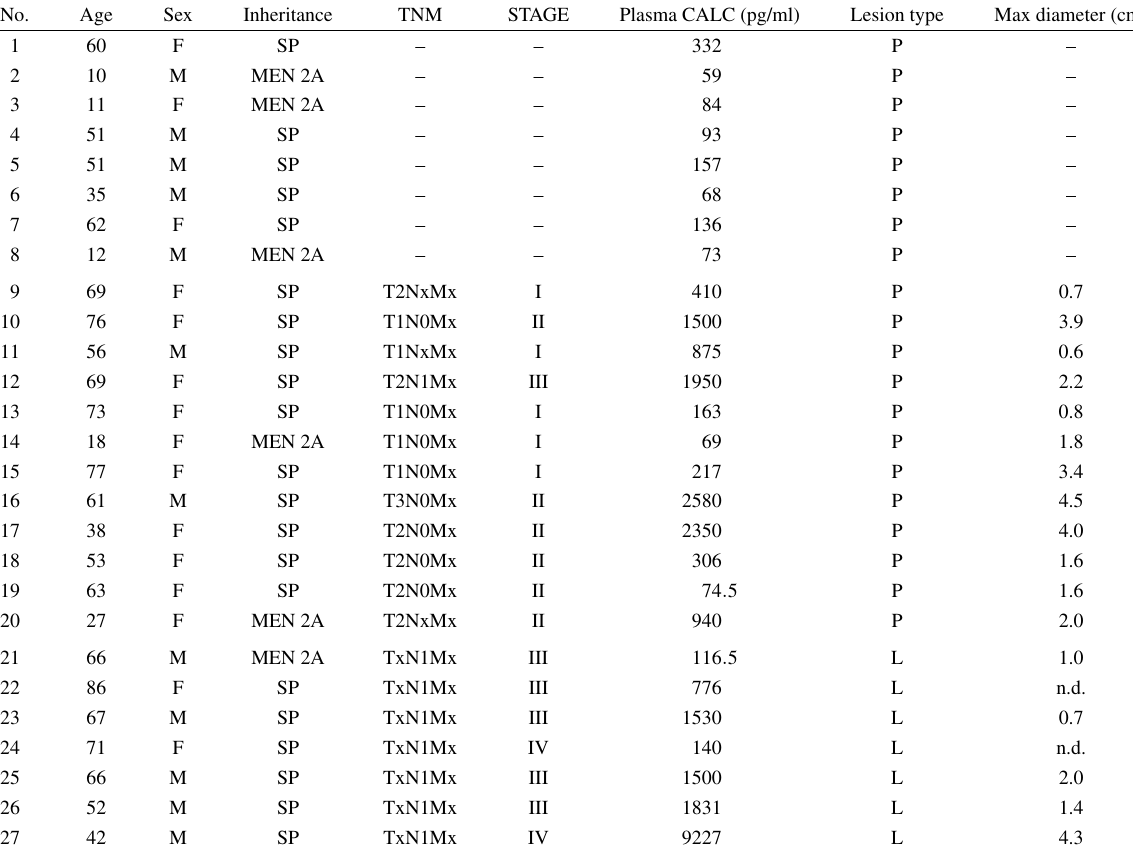
Characteristics of CCH and MTC